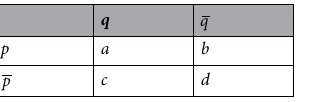
Table 1. 2 × 2 Contingency table of the LS